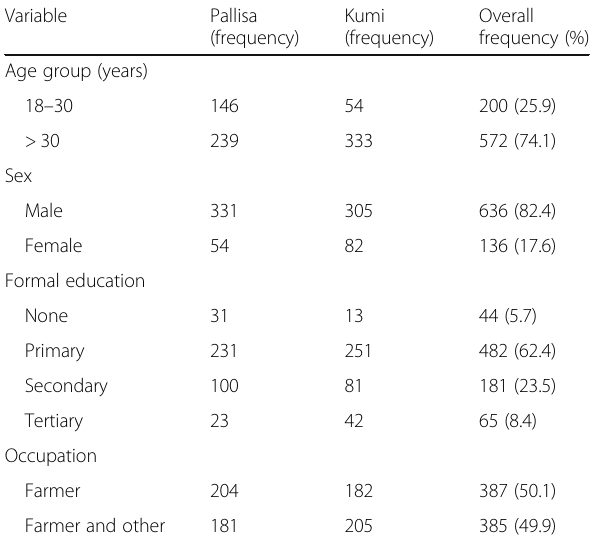
Table 1 The socio-demographic characteristics of farmer